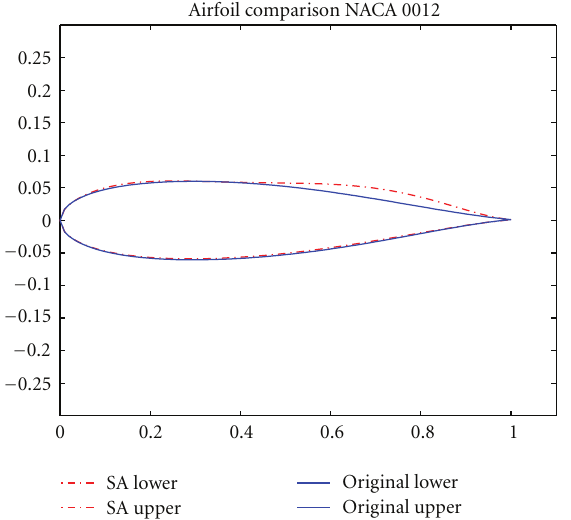
Figure 5: Comparison of original NACA 0012 airfoil and optimized airfoil using GA.